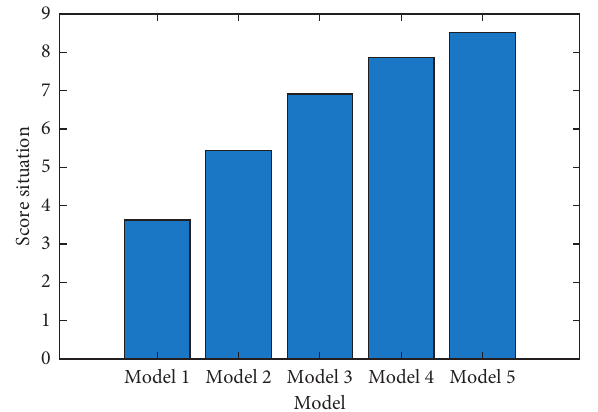
Figure 2: Dance authenticity rating chart.